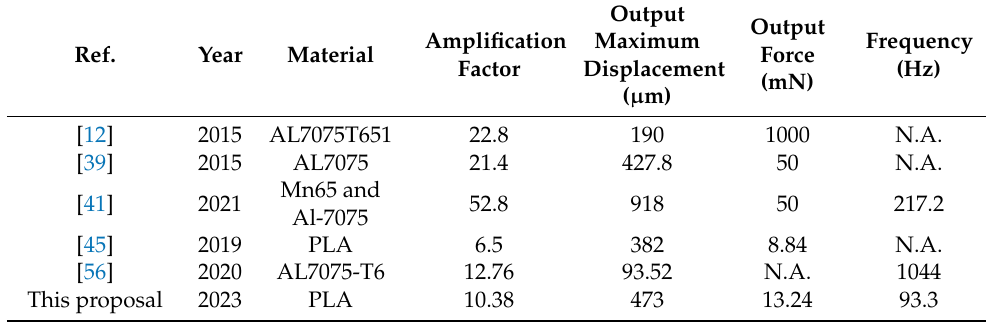
Table 7. Comparison of the proposed MG with other grippers based on piezoelectric actuation.